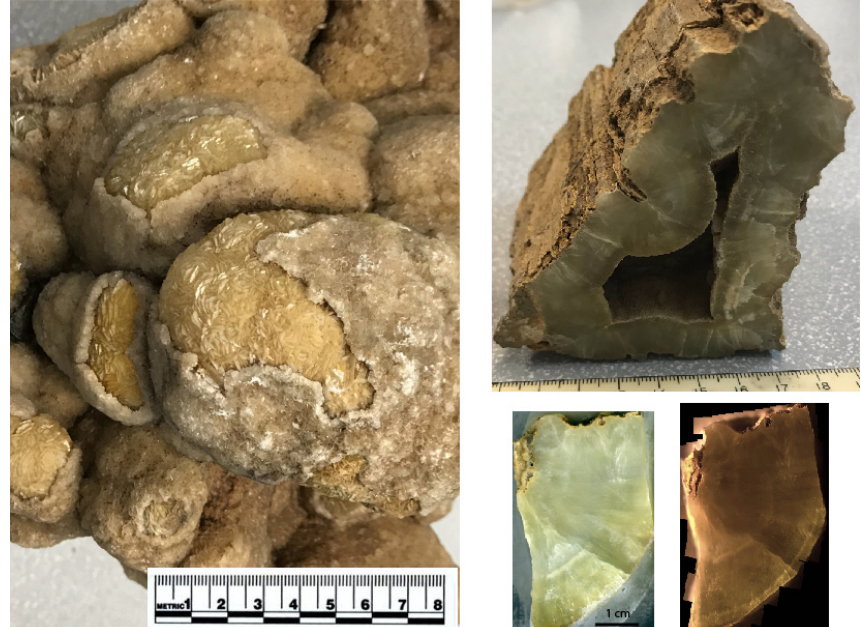
Figure 17. Hand samples of the Turkana dolomite sample: both samples came from an area where carbonates were coating tree trunks. The big sample is taken from a very large cavity that was filled by calcite, then by the yellow dolomite that is peeking out, and finally by a coating of grey calcite. The smaller triangular-shaped sample has a bark texture on the outside and appears to have precipitated in the cavity between three logs. The thickness of the dolomite layer is about 2cm and it coats every surface in this paleo-log pile. The small slabs come from the smaller of the two samples. The image on the left is the scanned slab used for XRF studies, and the one on the right is a CL photo mosaic with 459